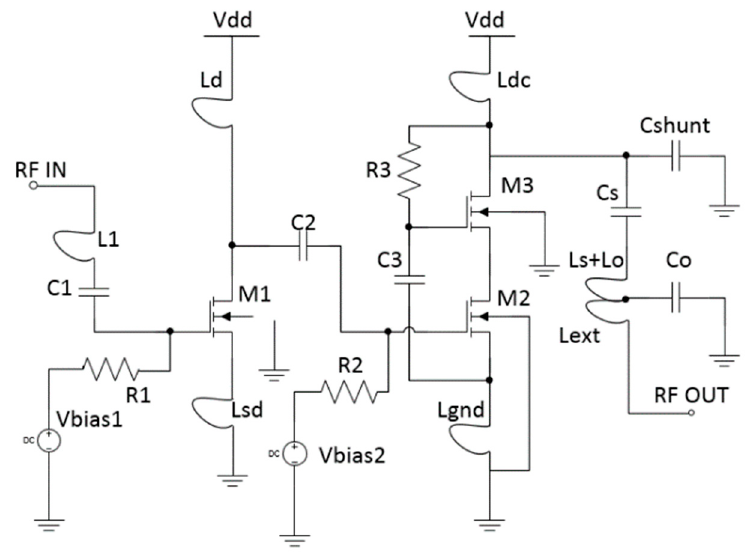
Figure 9. Schematic of class-E self-biased cascode PA [37].